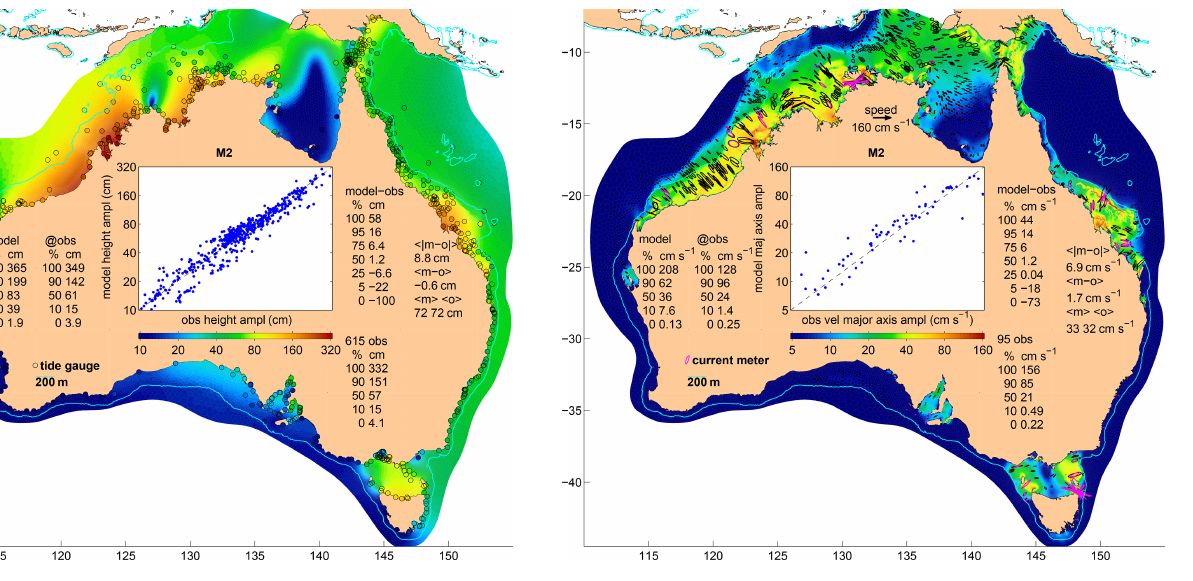
Figure 3. M2 height amplitude as a colour-fill map (the model) and points (observations); inset as a quantity–quantity plot. Statistics listed are percentiles (% columns) of (1) the model height field at all grid points (“model” column at left), (2) the model at observa- tion sites, hereafter m (“@ obs” column), (3) model error (“model- obs” column), and (4) the observed values o of which there are 615 within the area shown (“615 obs” column). At far right the follow- ing are listed: (cid:104)| m − o |(cid:105) , the mean of the absolute value of m − o ; (cid:104) m − o (cid:105) , the mean error, or bias; and (cid:104) m (cid:105) and (cid:104) o (cid:105) , the mean modelled and observed amplitudes. A log scale is used, starting at 10cm, so not all points can be shown.